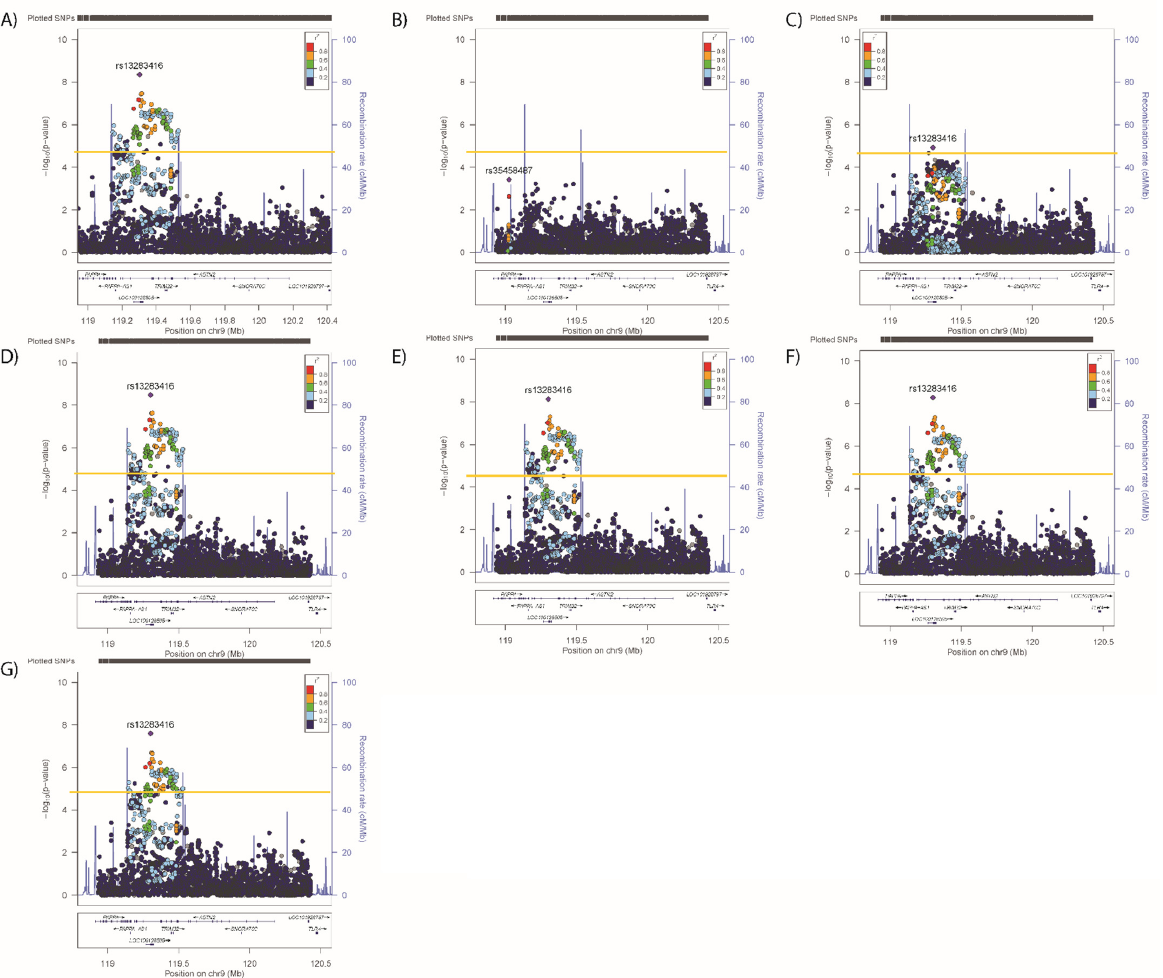
Figure 5. Regional plots for associations between ASTN2 and ( A ) WHRadjBMI, adjusted for the primary SNP for ( B ) WHRadjBMI, ( C ) SBP/DBP, and ( D ) BMI, ( E ) neuroticism, ( F ) anhedonia and ( G ) mood instability. Significance was set at p -value < 5.45 × 10 − 5 or − log10 > 4.26 (Horizontal yellow line). LD (r2) with the lead SNP are indicated by colour. Grey indicates that there is no LD information available.